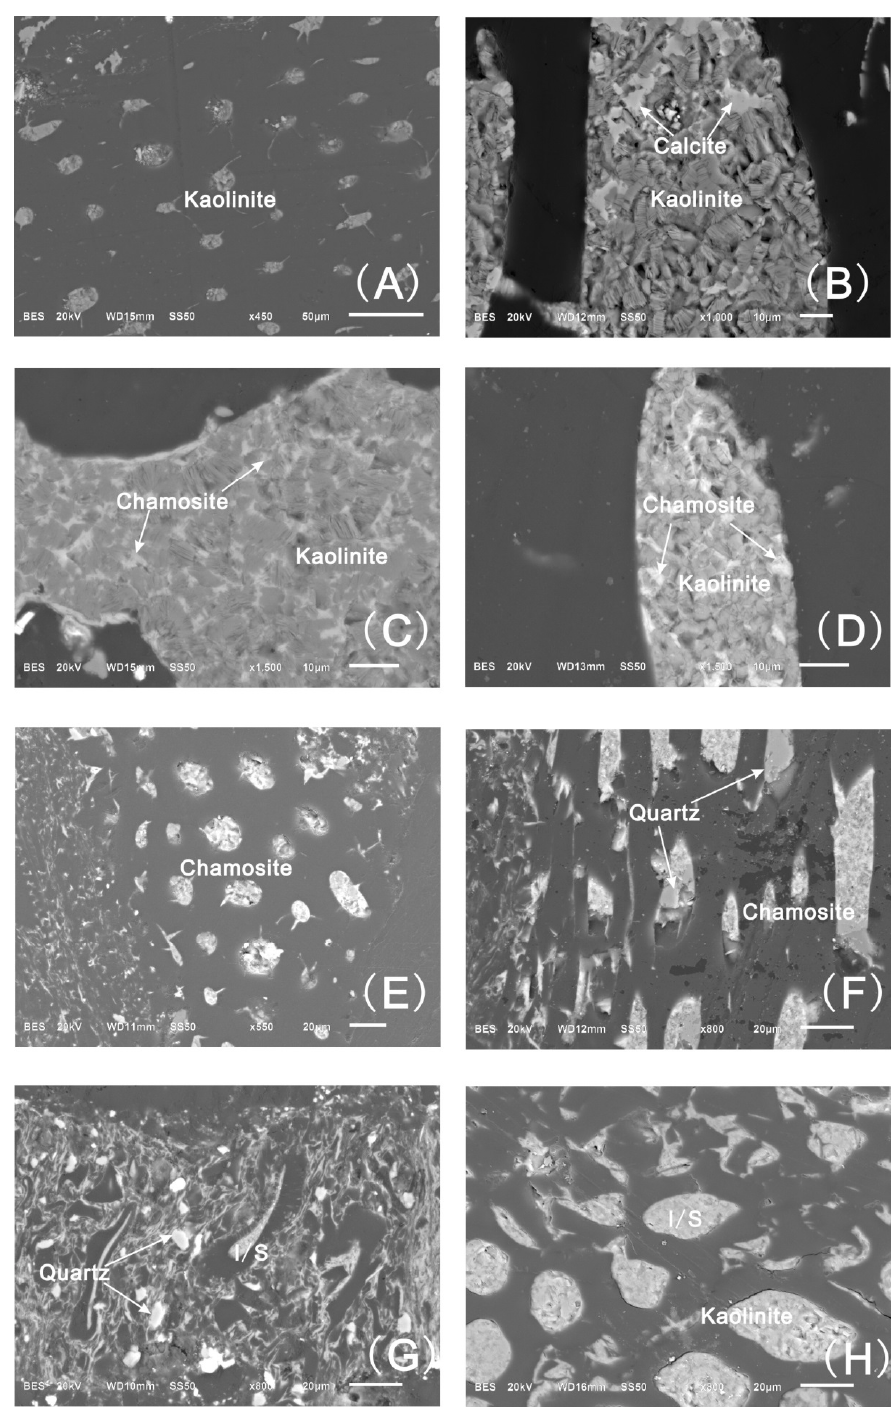
Figure 3. Scanning electron microscope (SEM) back-scattering images of minerals in the Zhongliangshan coals. ( A ) cell-filling kaolinite in sample K8-1; ( B ) cell-filling kaolinite and calcite in sample K1-1; ( C ) cell-filling kaolinite and chamosite in sample K5-1; ( D ) cell-filling kaolinite and chamosite in sample K5-2; ( E ) cell-filling chamosite in sample K4-2; ( F ) cell-filling chamosite and quartz in sample K10-5; ( G ) I/S and quartz occurred in the matrix in sample K10-4. (H) cell-filling I/S and kaolinite in sample K4-1.